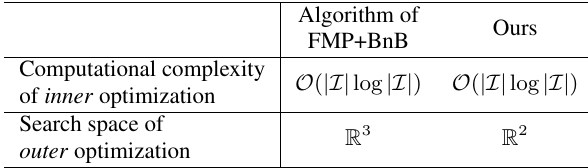
Table 1. Computation-cost comparison between algorithm of FMP+BnB’s and our